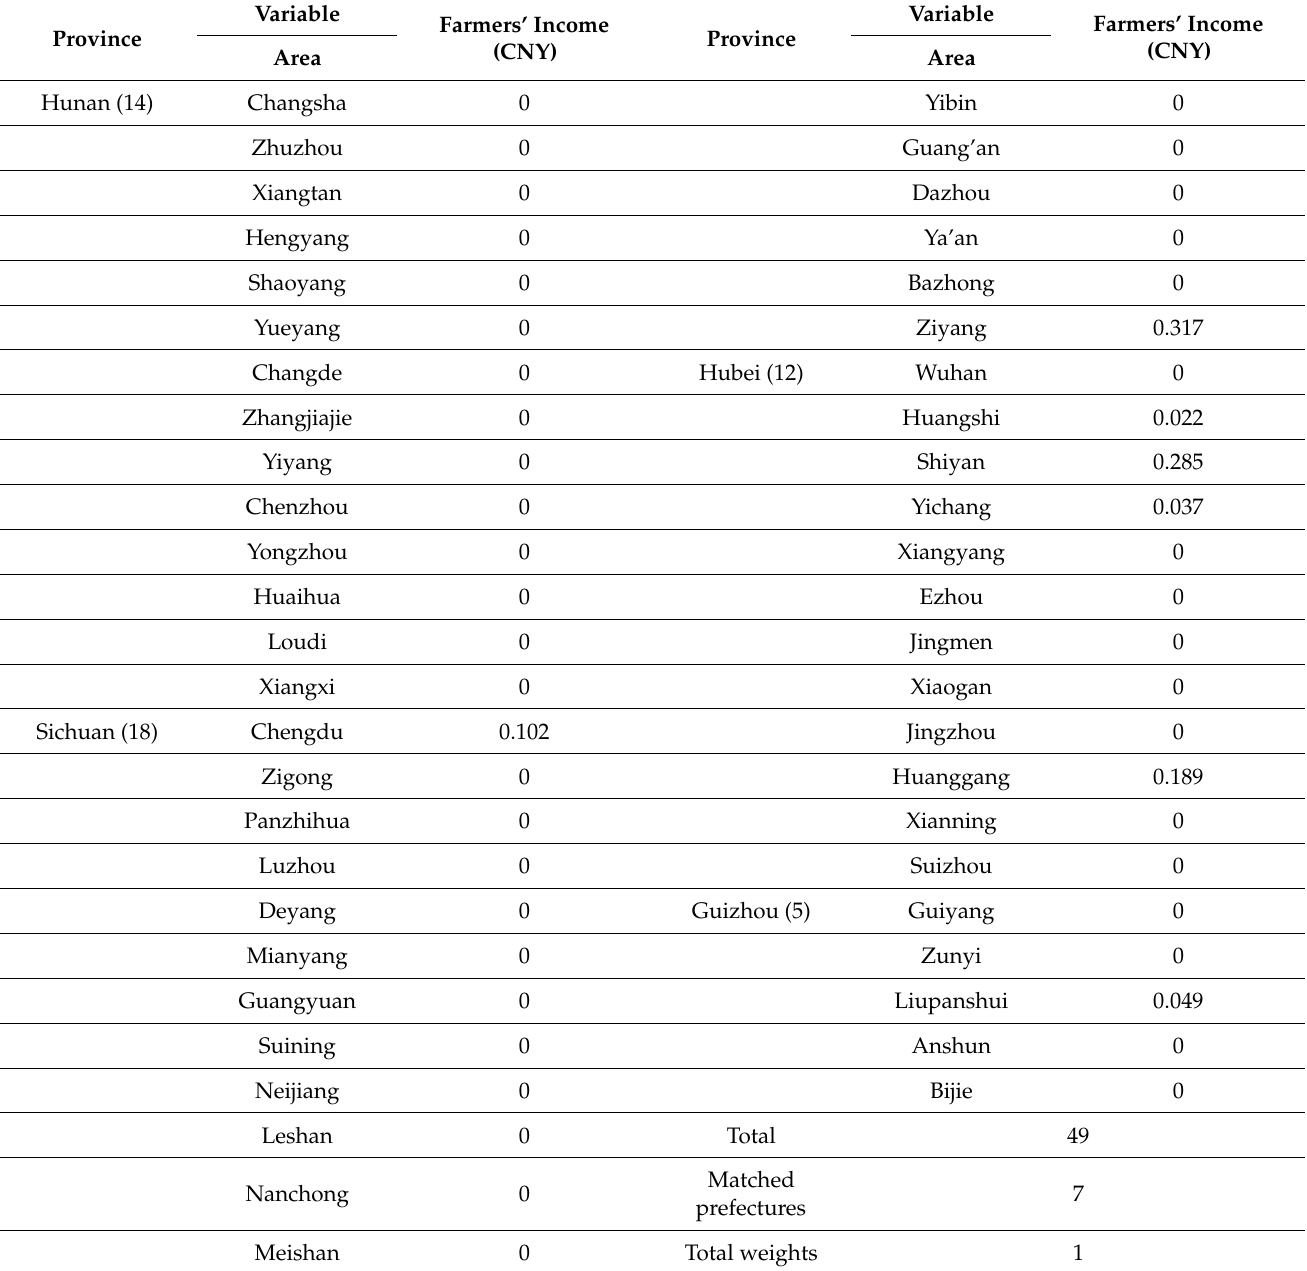
Table 4. Synthetic area weight value combination